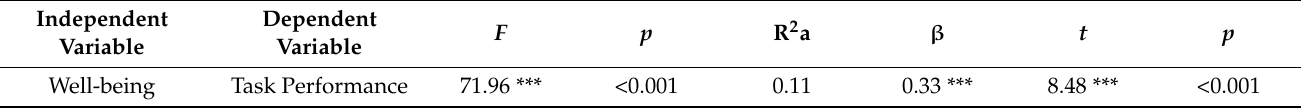
Table 6. Simple linear regression results (H3).